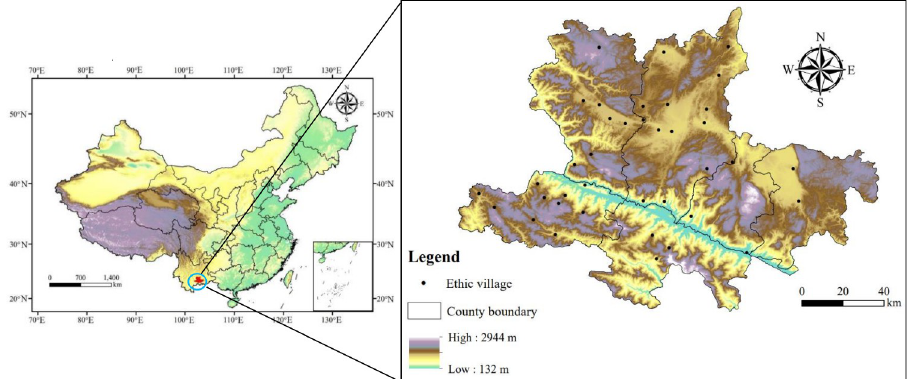
Fig 1. The location of the study area and the traditional ethnic